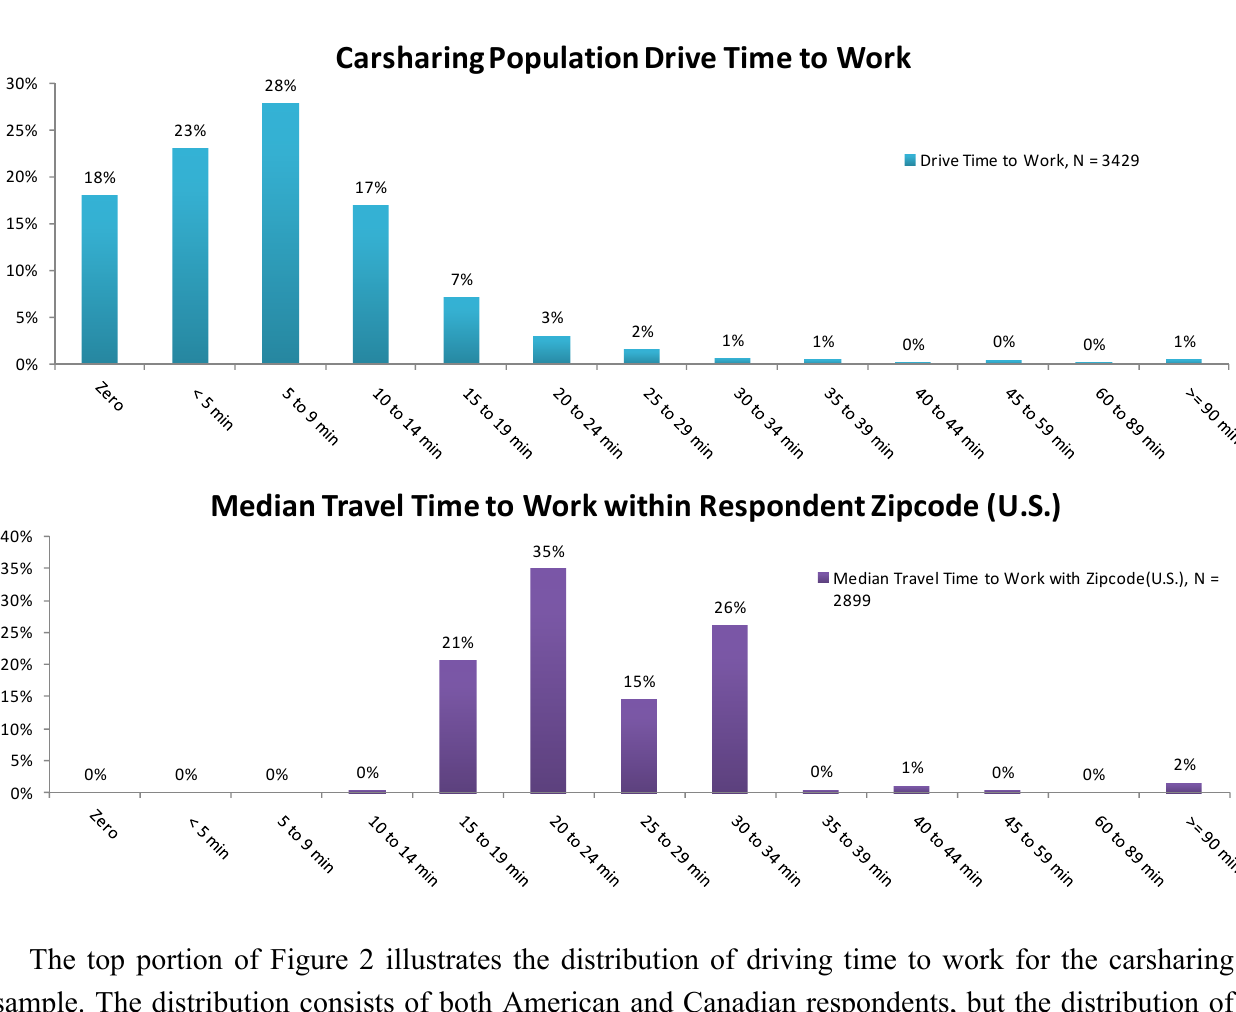
Figure 2. Comparison of Travel Time to Work of North American Carsharing Members and the U.S.